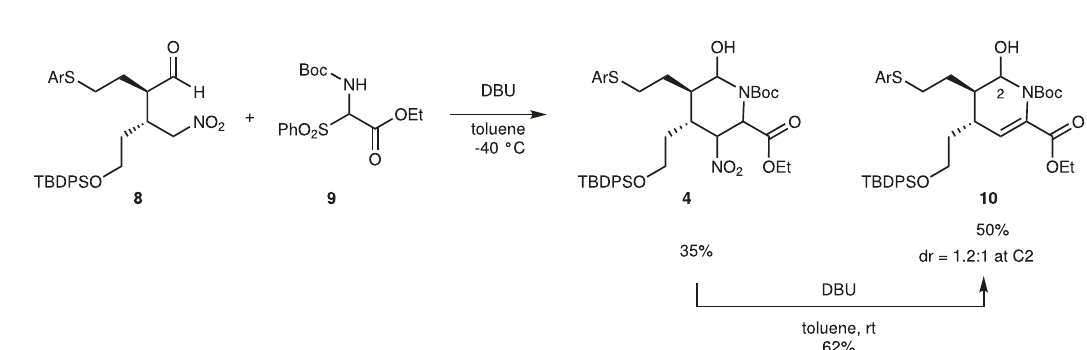
Fig.5|Aza-Henry,hemiaminalization,andeliminationreaction. Insitugenerationofiminefrom 9 usingDBUwasthekeytoobtain 4 and 10 . 4 couldbeconvertedto 10 by DBU. DBU 1,8-diazabicyclo[5.4.0]undec-7-ene.